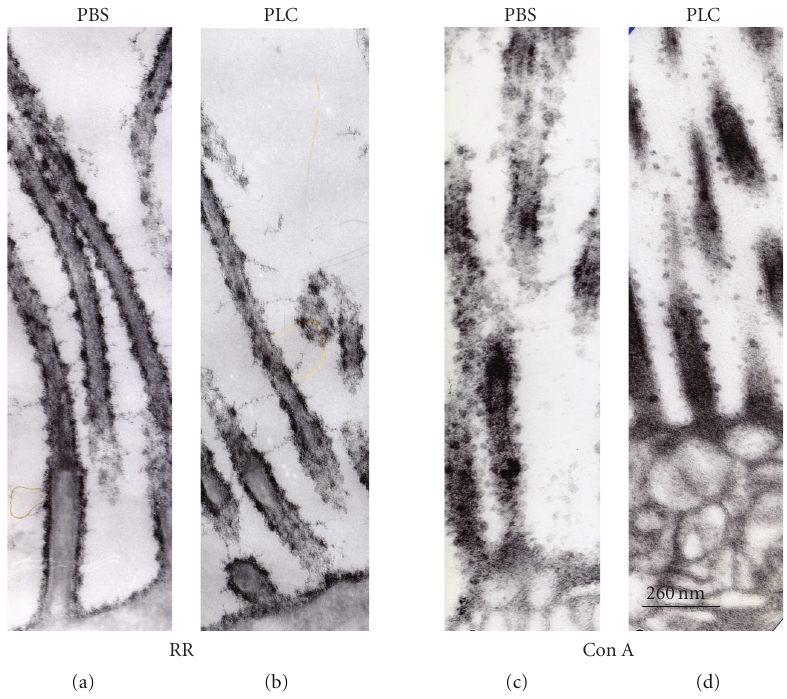
Figure 4: Electron micrographs of the tegumentary microtriches of Taenia solium cysticerci, after 1 hour incubation with PBS and PLC. Sections of the bladder wall were (a) and (b) stained with ruthenium red (RR) and (c) and (d) incubated with concanavalin A (ConA)-